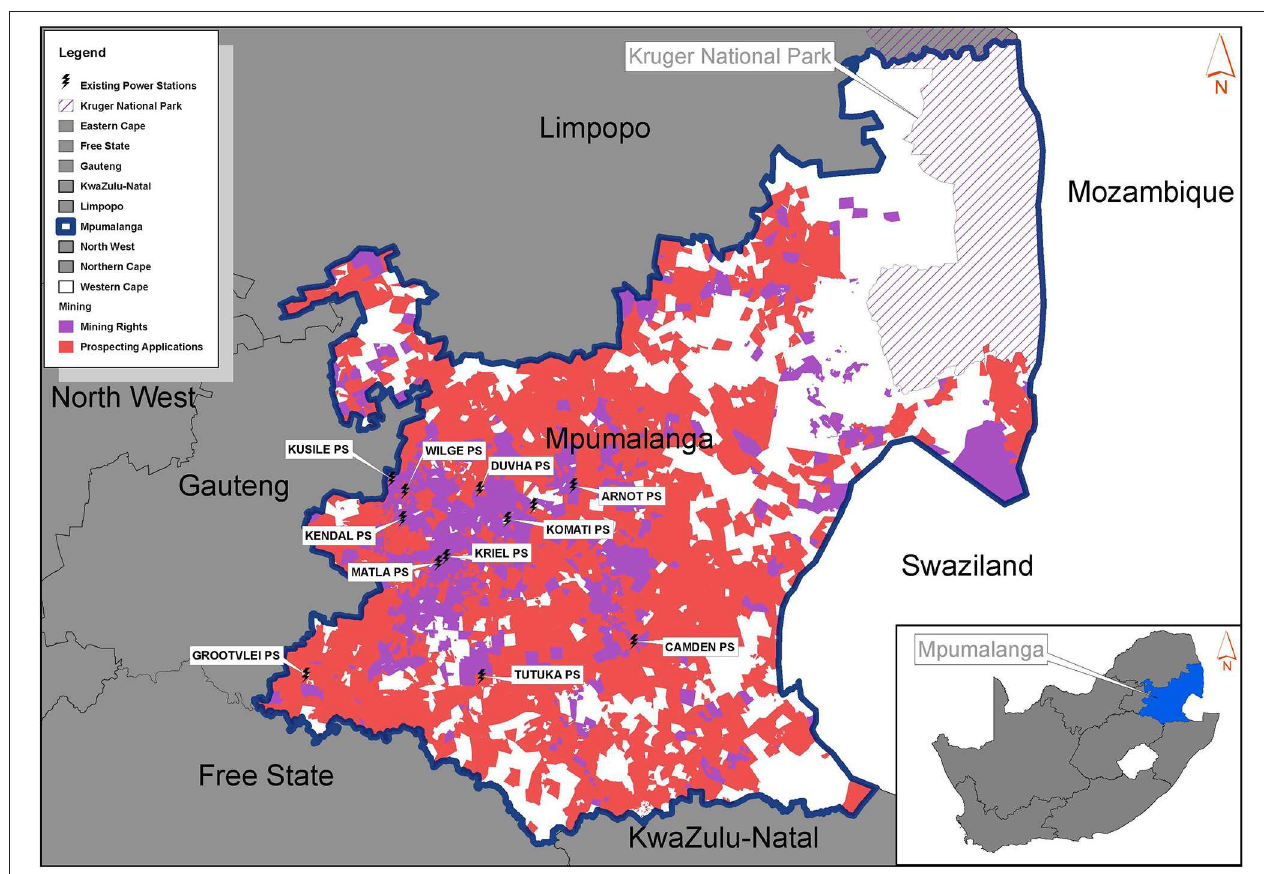
FIGURE 2 | Map of the Mpumalanga Province indicating the location of power stations, mining rights areas, and farm portions where prospecting applications have been submitted ( Lotter,